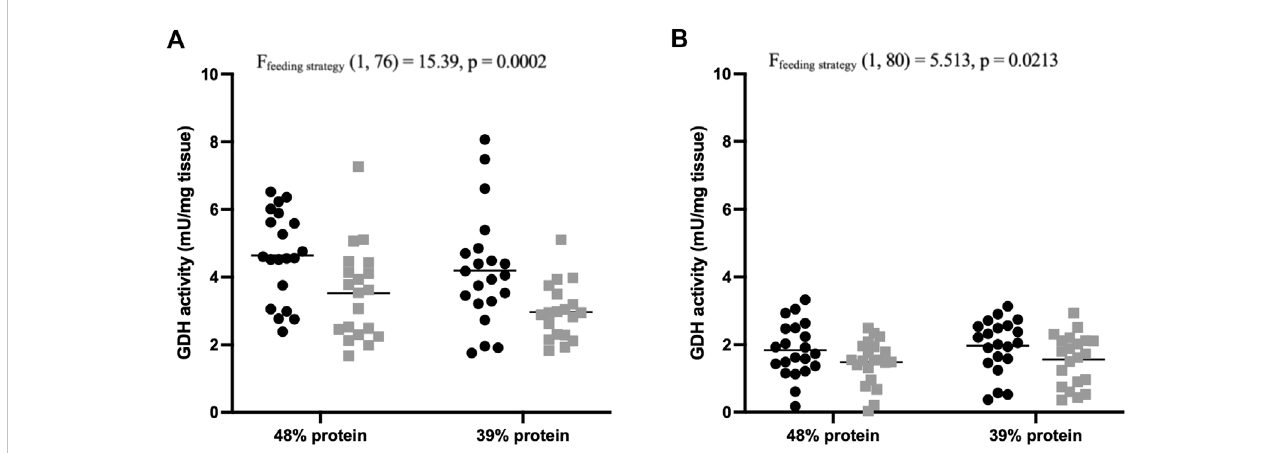
FIGURE 4 Glutamatedehydrogenaseactivityofcarpliverandproximalintestines. (A) HepaticGDHactivities(mU/mgtissue)ofdemand-fedandbatch-fedcarpfed (cid:129) differentdietary proteincontents( n =21pertreatment). Demand-fedindividualsareshown asblackcircles ( ),batch-fedindividualsasgreysquares( ■ ).Each point represents themean activity (from duplicate measurements) of a single carp. Horizontal barsindicate mean activity. Signi fi cance was tested with a two- way ANOVA with the factors ‘ Feeding strategy ’ and ‘ Dietary protein ’ . Feeding type had a signi fi cant effect on hepatic GDH activity ( p = 0.0002). (B) Intestinal GDH activities (mU/mg tissue) of demand-fed and batch-fed carp fed different dietary protein contents ( n = 21 per treatment). Demand-fed (cid:129) individuals are shown as black circles ( ), batch-fed individuals as grey squares ( ■ ). Each dot represents the mean activity (from duplicate measurements) of a single carp. Horizontal bars indicate mean activity. Signi fi cance was tested with a two-way ANOVA with the factors ‘ Feeding strategy ’ and ‘ Dietary protein